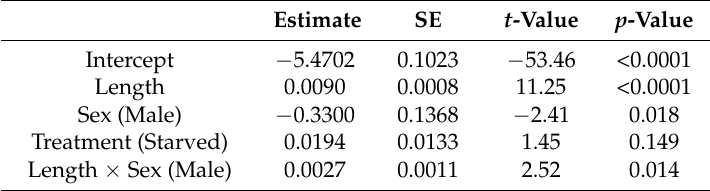
Figure 3. Effectsofsexon( A )braindrymass, ( B )intestinedrymass,( C )brain-intestine-index,( D )headlength, all in relation to fork length. Lines are based on local regression (LOESS) in ( A , B , D ), and on linear regression in ( C ). Grey-shaded areas around regression lines show the 95% confidence limits. Table 1. Parameter estimates from the linear model of brain dry mass, with statistical summary. SE = standard error.